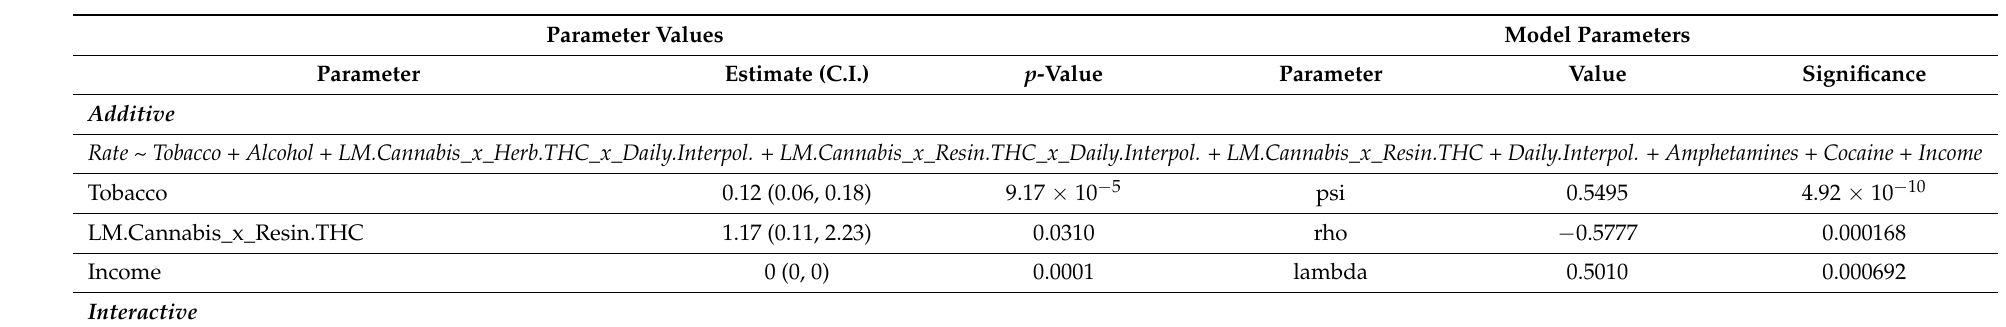
Table 3. Geotemporospatial Regressions for Multicystic Renal Disease Congenital